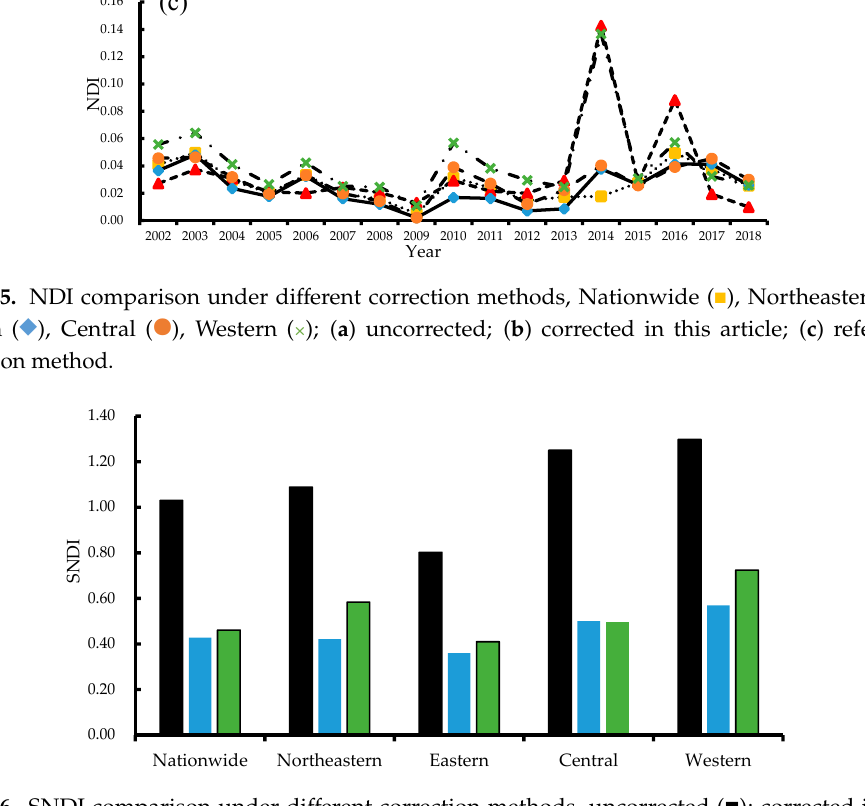
Figure 6. SNDI comparison under different correction methods, uncorrected ( ■ ); corrected in this article ( ■ ); reference correction method ( ■ ).